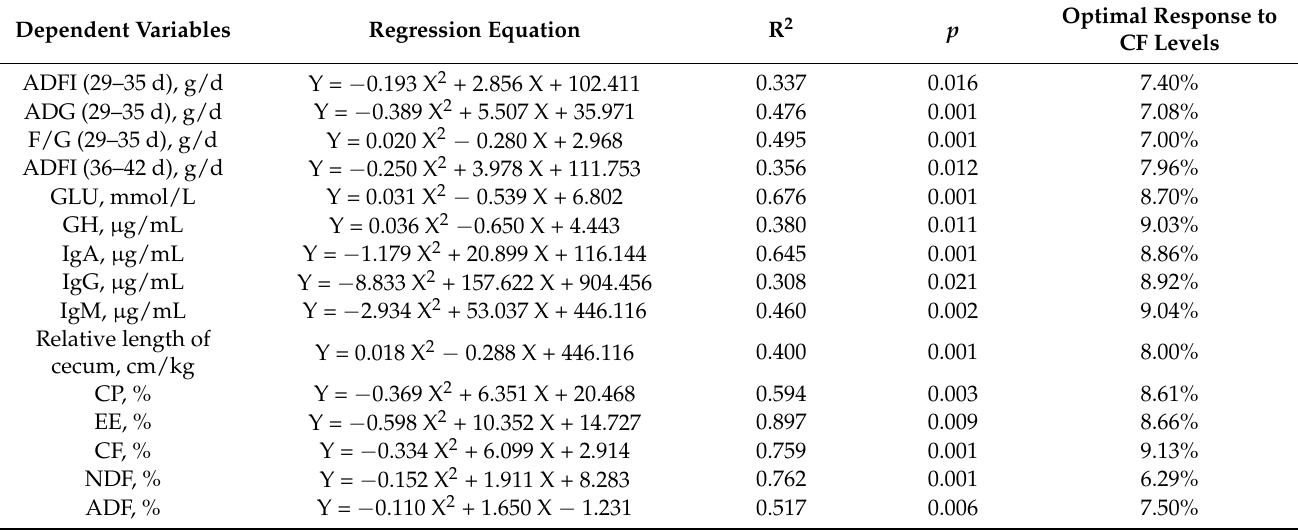
Table 3. Estimation of the optimal response for dietary CF levels based on quadratic regressions in broilers.